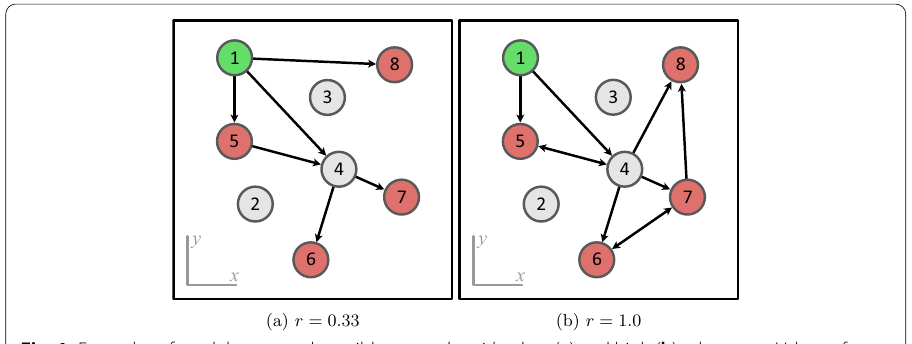
Fig. 1 Examples of model setup and possible networks with a low ( a ) and high ( b ) robustness. Values of r are indicated below each network. In ( a ), E r = ( 1,4 ) , ( 5,4 ) , M reducing the demand stisfaction, | E r | = M =